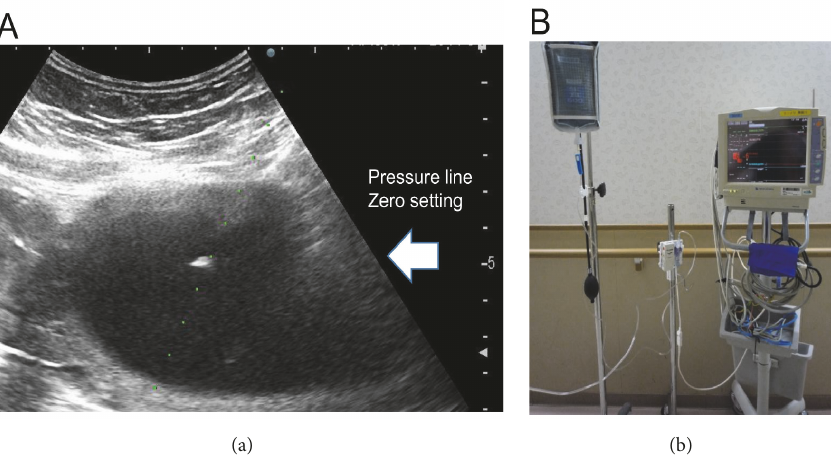
Figure 1: (A) Ultrasound and zero pressure level line setting during amnioreduction for polyhydramnios. (B) Circuit that includes a silicone stain-gauge transducer (DX-300, Nihon Koden) for measuring